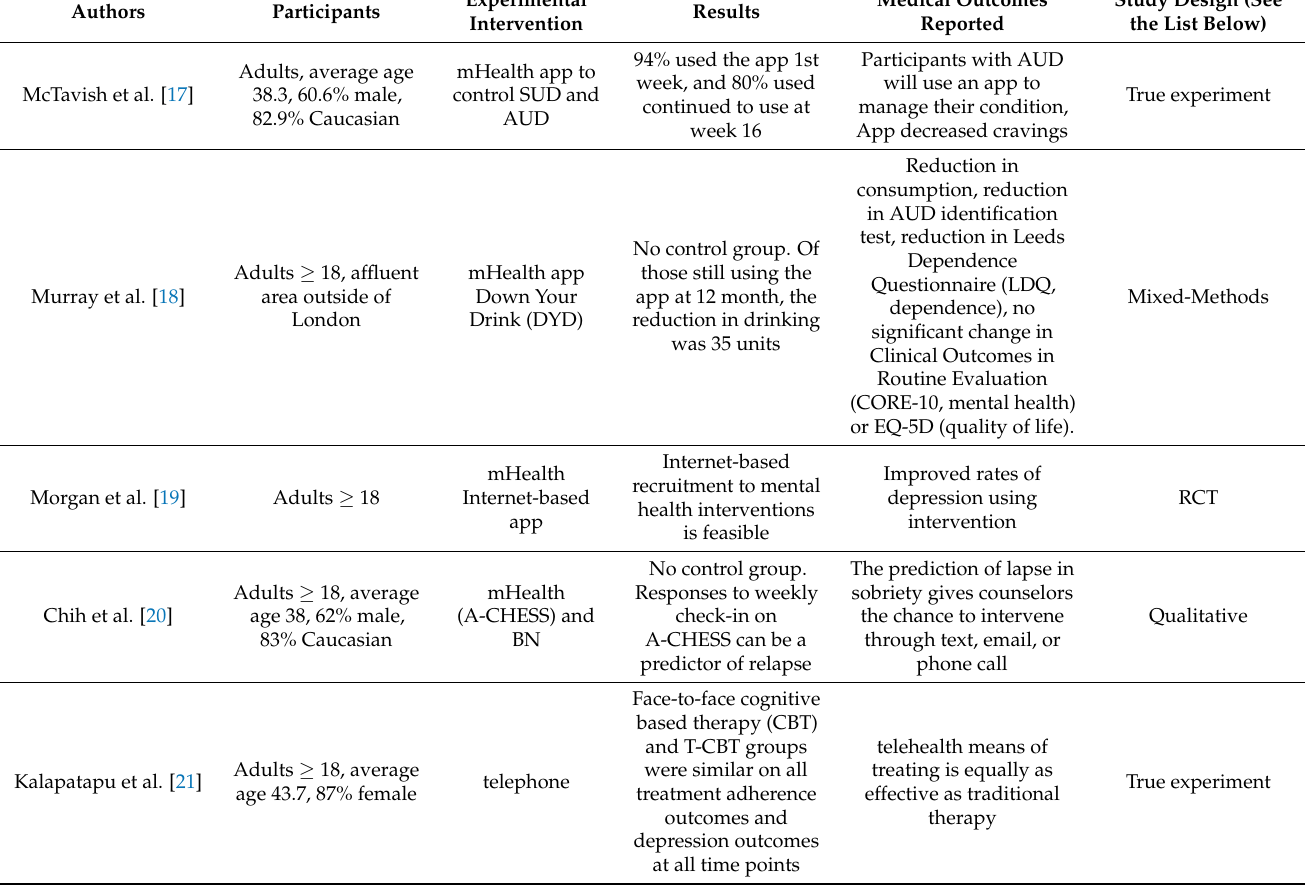
(56%) were randomized controlled trials, 4/26 (16%) were true experiments, 2/26 (8%) were non-experimental and 2 were mixed-methods, and 2 were observational, and 1/26 (4%) was qualitative. Results showed a reduction in consumption in 15/31 (45%) results themes, but also no significant difference in treatment outcomes in 5/31 (16%) results